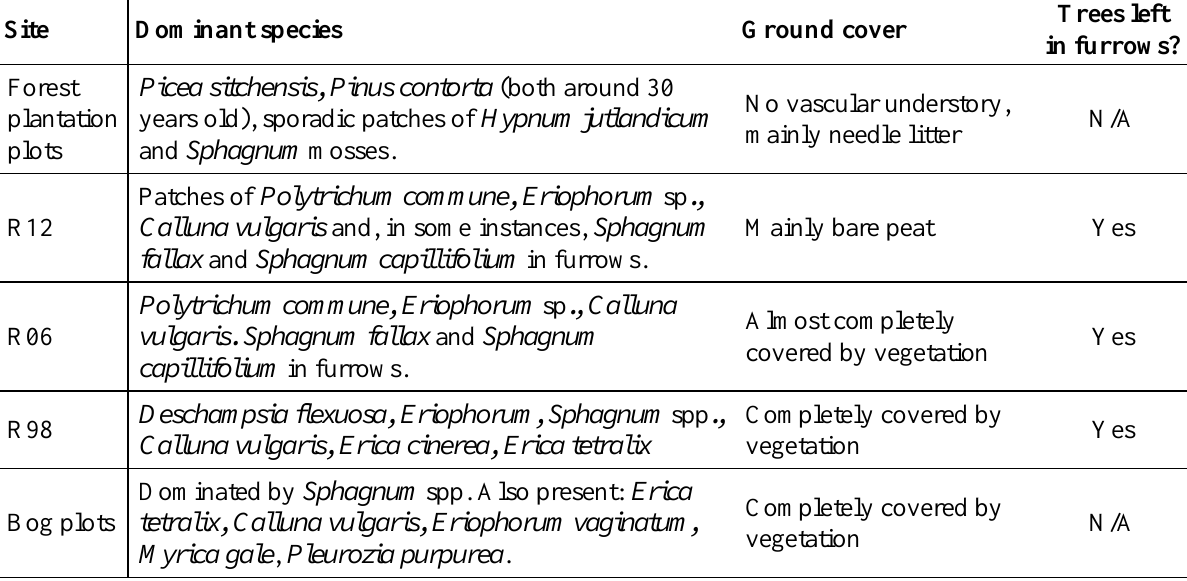
Table 1. Site descriptions, with dominant species, ground cover and destination of trees after felling.